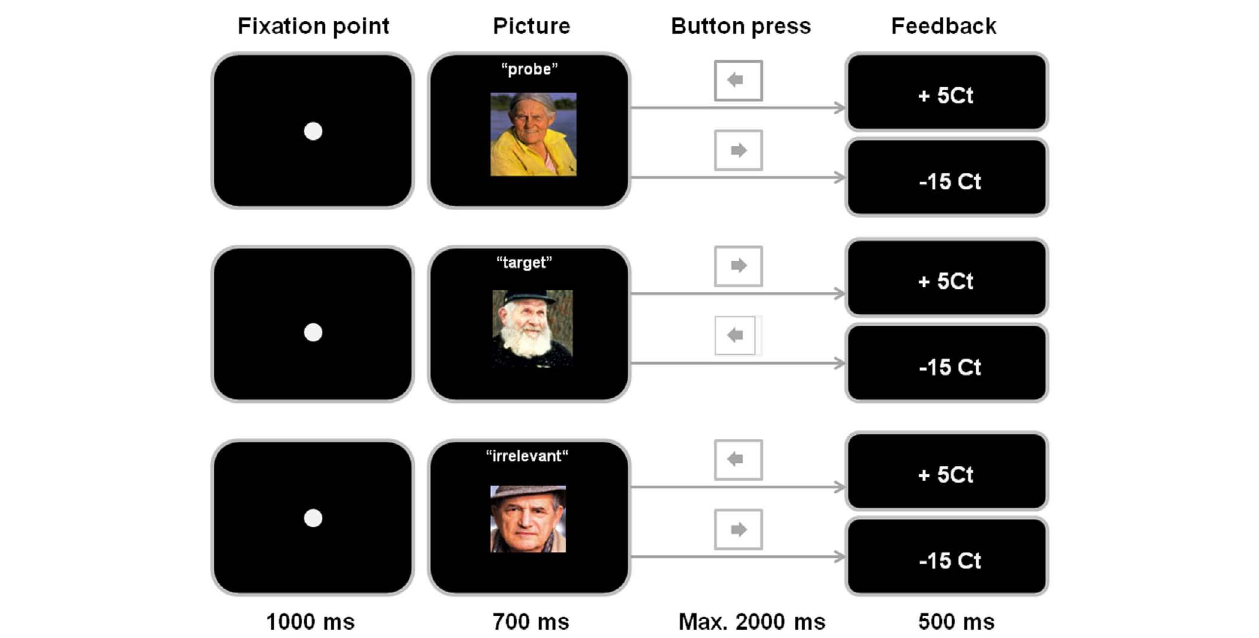
FIGURE 1 | Sequence of a probe item, a target item, and an irrelevant item. The inter-trial-interval (ITI), which was 1000, 1500, or 2000ms, is not presented in the